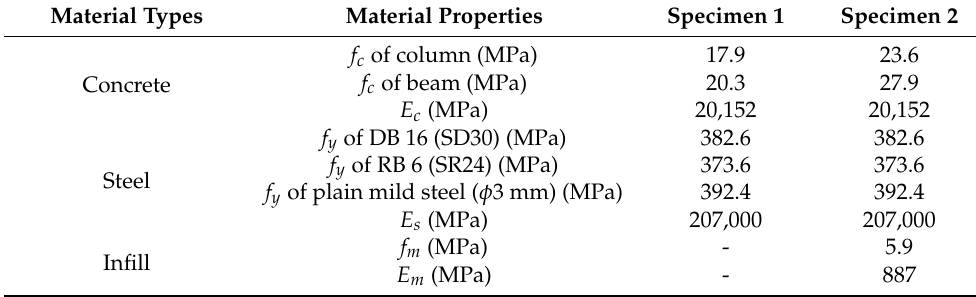
Table 2. Material properties of Niyompanitpattana and Warnitchai